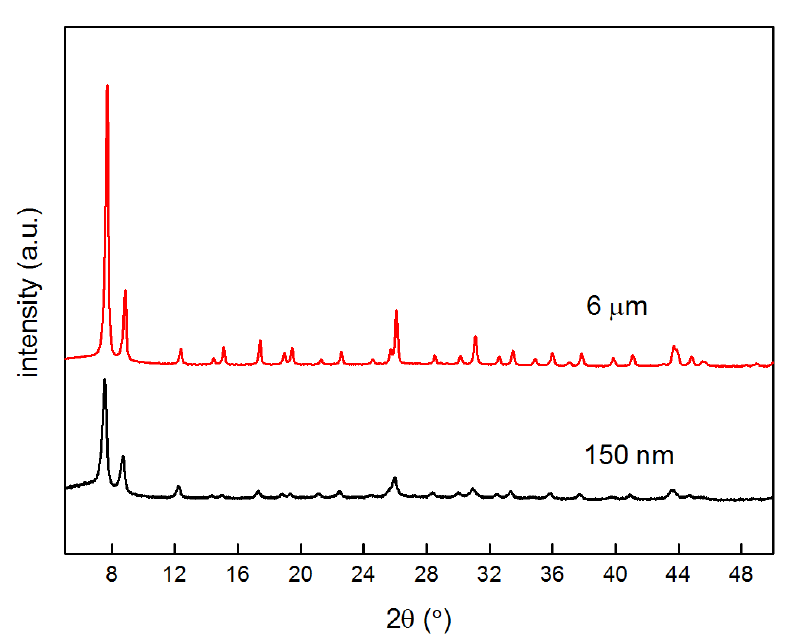
Figure 3. XRD patterns of UiO-66 with two crystal sizes.